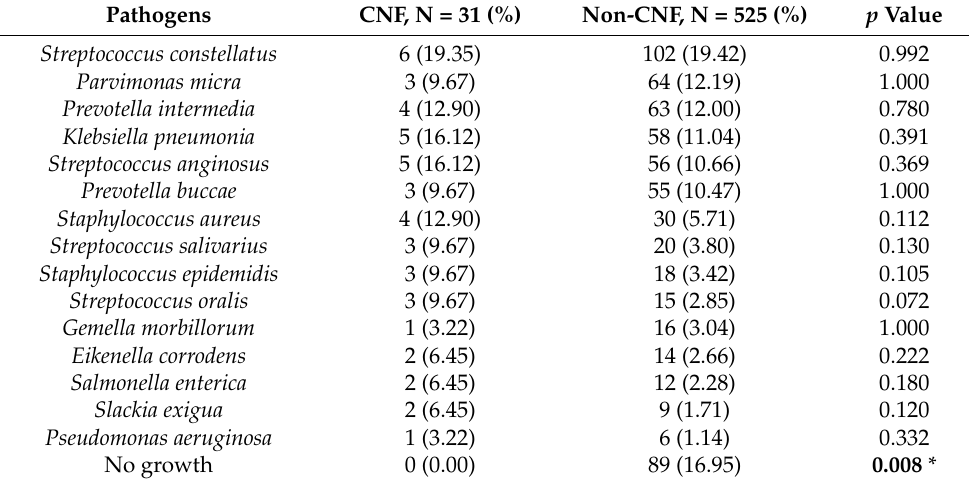
Table 4. Comparison of pathogens between 525 patients with DNI alone compared to 31 patients with concurrent DNI and